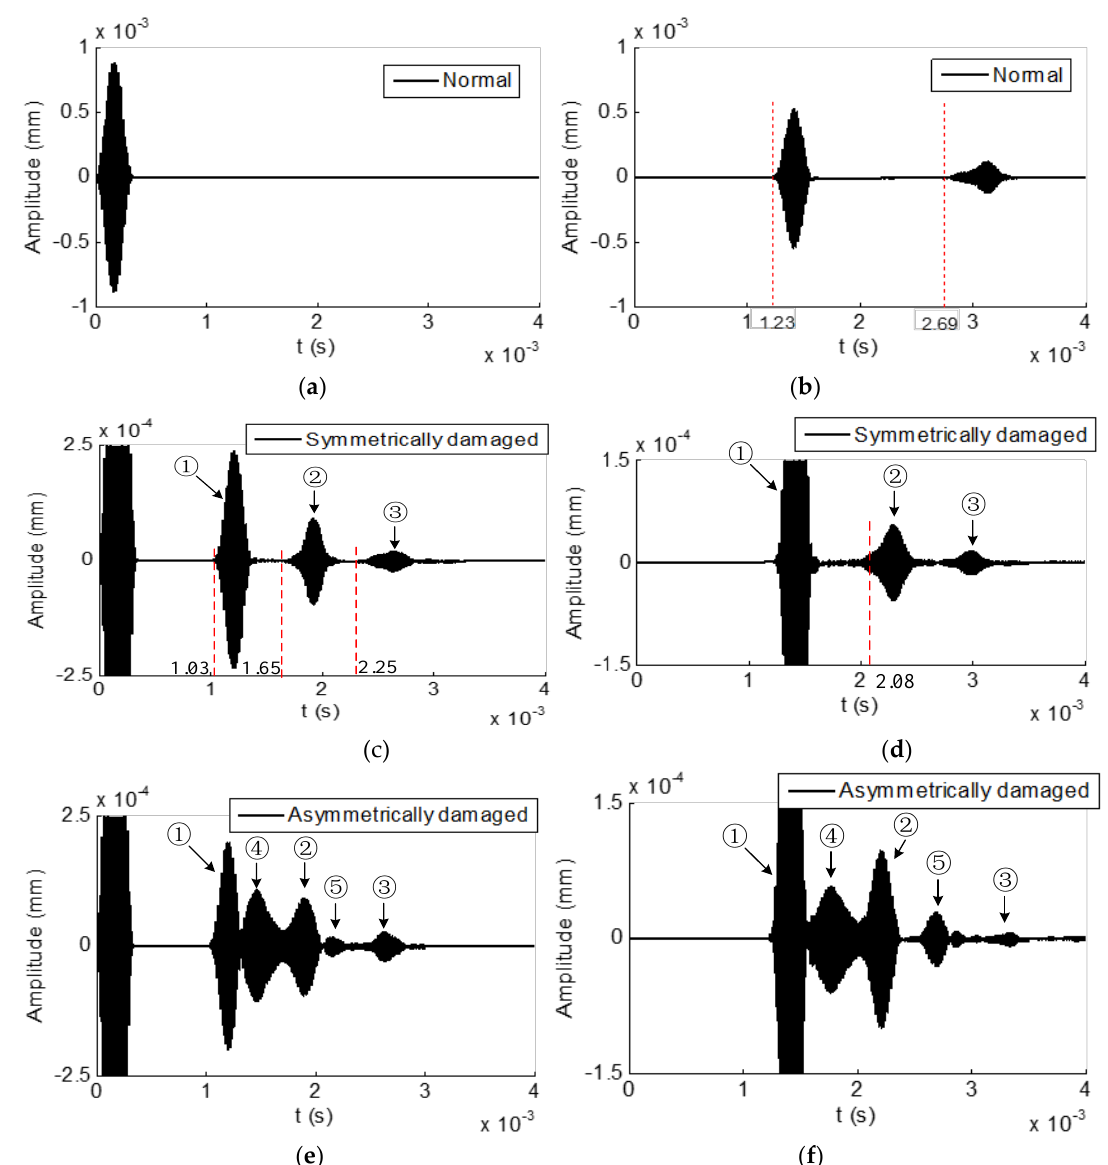
Figure 15. Time domain waveforms received from hexagonal drill pipes under the excitation of axial surface traction at the center frequency of 60 kHz: ( a ) and ( b ) reflected and transmitted waves from a normal hexagonal drill pipe, respectively; ( c ) and ( d ) reflected and transmitted waves from a symmetrically damaged hexagonal drill pipe, respectively; and ( e ) and ( f ) reflected and transmitted waves from an asymmetrically damaged drill pipe, respectively.